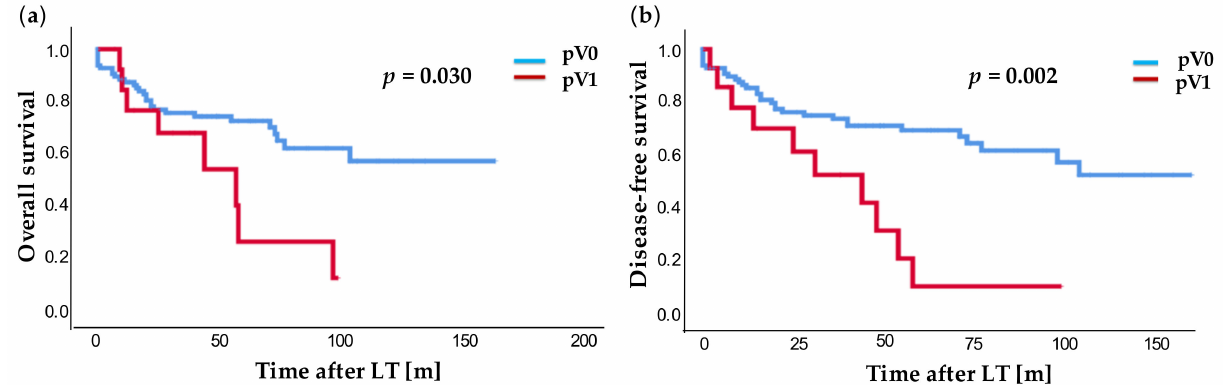
Figure 3. Overall survival ( a ) and disease-free survival ( b ) after LT with (red) and without (blue) microvascular infiltration. Time in years [y].